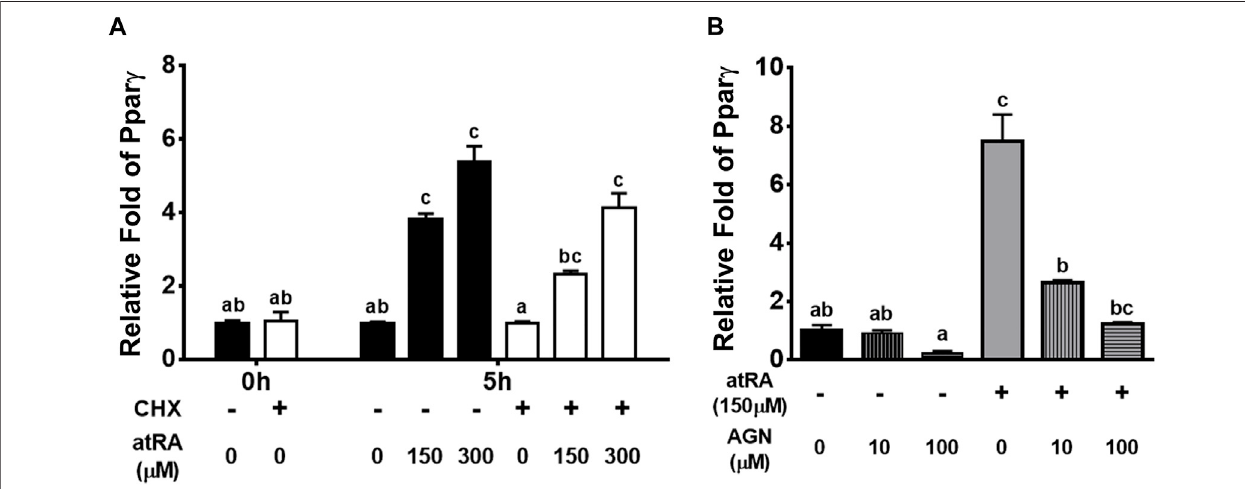
FIGURE 5 | Induction or suppression of Ppar γ expression by atRA on the condition of treating cycloheximide or RAR antagonist, respectively, in QM7 cells (A) Direct regulation of Ppar γ by atRA. Cycloheximide (CHX) was pre-treated for 1 h and then, after washing with PBS, atRA was treated in 10% CS with three different concentrations, 0 M, 150 μ M, or 300 μ M, for 5 h. The mRNA levels of Ppar γ at 1 h after non-treatment of CHX were set as a standard for normalization of relative fold changes (B) Suppression of atRA-inducted Ppar γ expression by an RAR antagonist. Various concentrations (0 M, 10 μ M, and 100 μ M) of RAR antagonist (AGN) weretreatedin10%CSwith150 μ MofatRA.After5 h,mRNAlevelsofPpar γ weremeasuredbyqPCR,andthegroupwhichis0 MofAGNwithout150 μ MofatRAwas set as a standard for normalization of relative fold changes. All data were shown as mean ± SEM ( n = 3 from 3 independent experiments). One-way ANOVA followed by Tukey ’ s multiple comparison test was used for statistical analysis by the GraphPad PRISM program. (A-C) indicates statements of signi fi cance, p < 0.05.